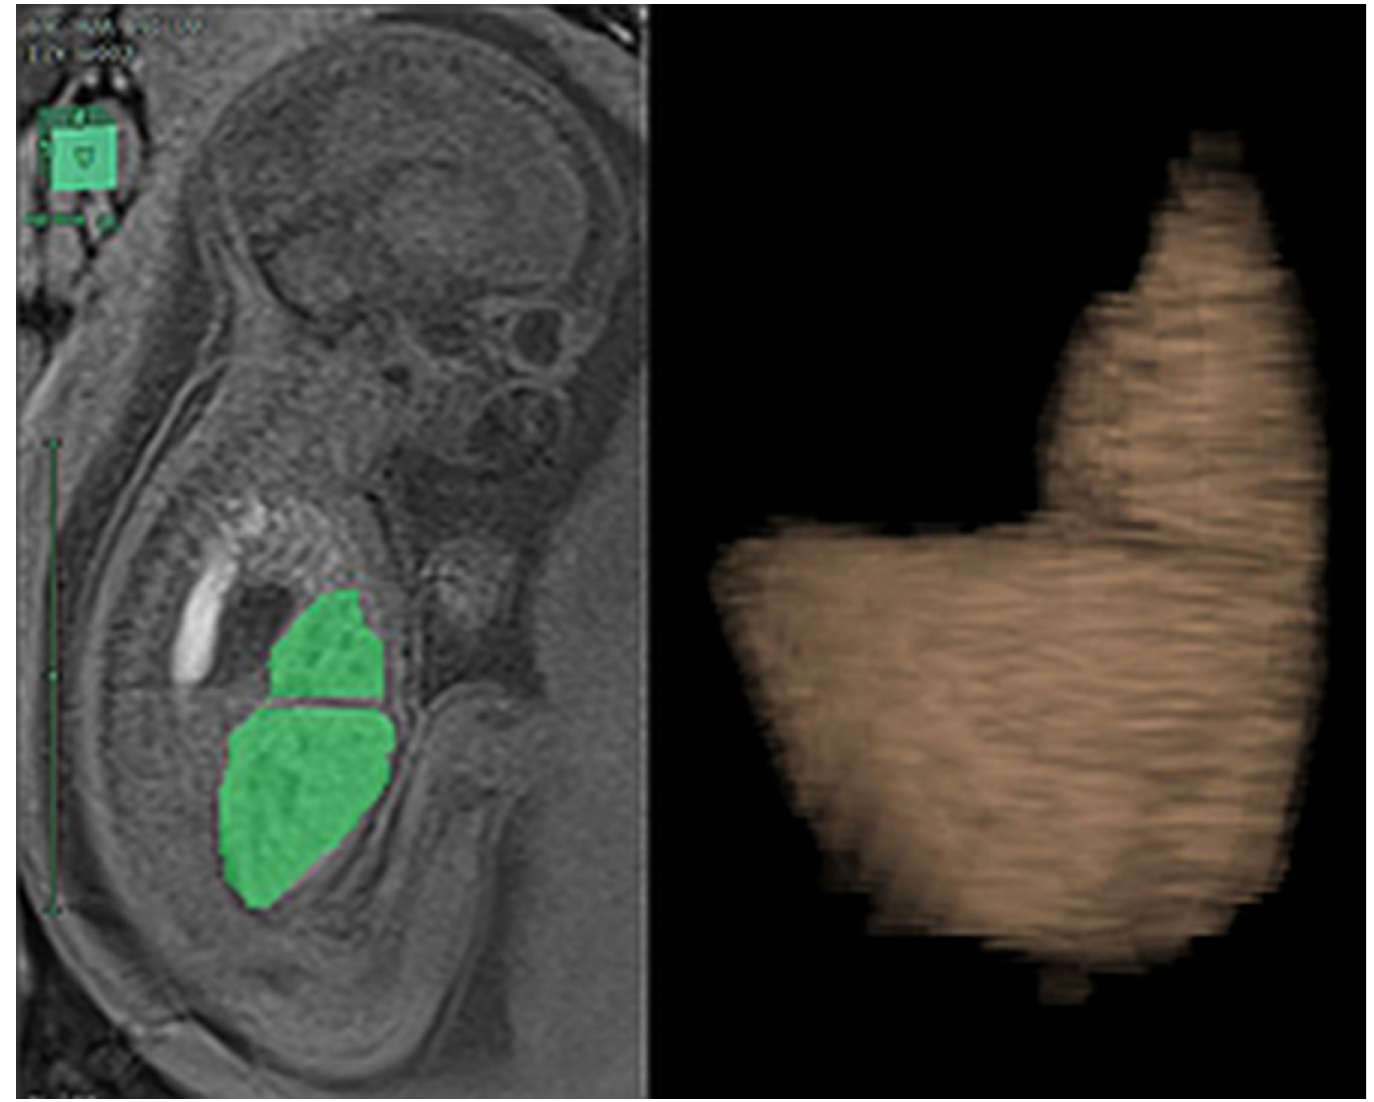
Fig 4. Liver volume assessment. MRI segmentation and 3D reconstruction of the fetal liver with the calculation of the herniated liver on T2-sequences.